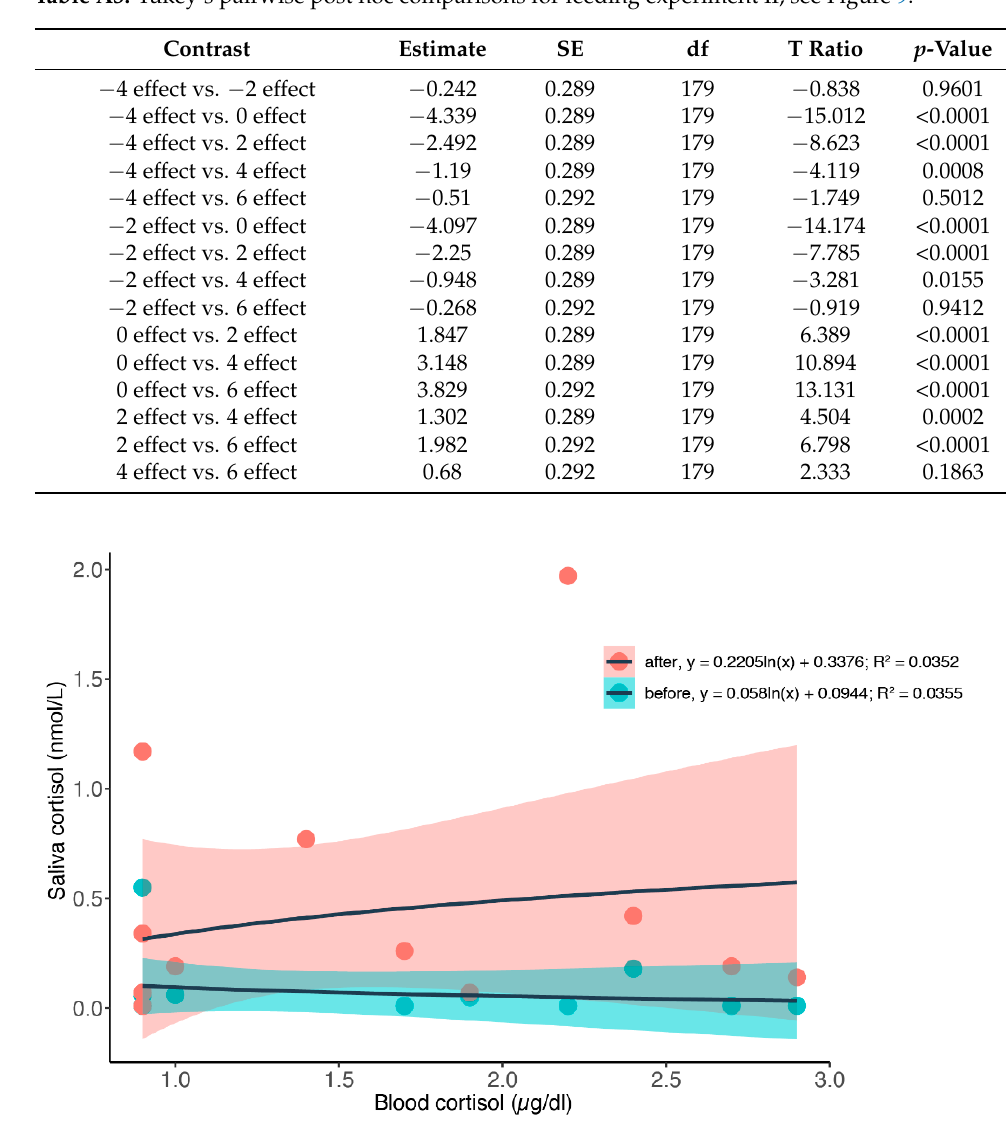
Figure A4. Correlation between blood cortisol values and saliva values during restriction. An expo ‐ nential curve was fitted. Saliva samples were taken before (green dots) and after (red dots) the blood samples; see Figure 3 for an exemplarily sampling scheme. Three dolphins were sampled (Jenny = 9 samples; Moby = 1 sample; Anke = 1 sample; Nami = 2 samples before, 3 samples after). References 1.